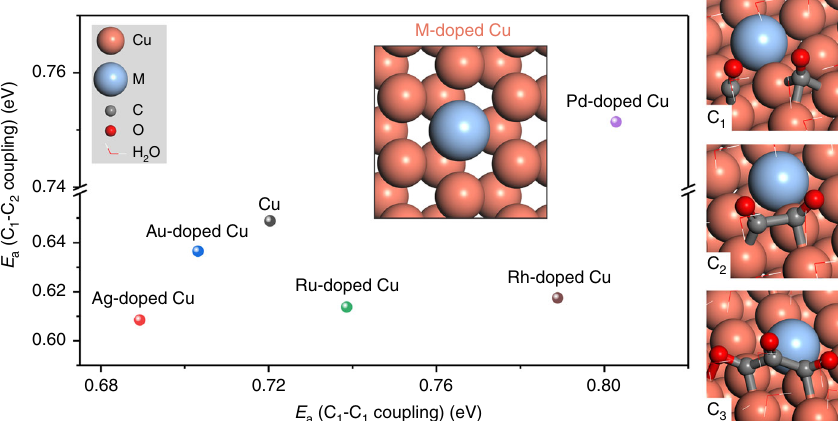
Fig. 1 DFT calculations on C 1 – C 1 and C 1 – C 2 coupling. DFT calculated reaction barriers ( E a ) for C 1 – C 1 and C 1 – C 2 coupling on screened M -doped Cu systems ( M = Ag, Au, Ru, Rh, and Pd). The geometries of M -doped Cu surface, C 1 , C 2 , and C 3 on M -doped Cu are shown with the corresponding labels, respectively. Cu, M, C, and O are illustrated as orange, light blue, gray, and red balls, respectively, while water molecules are shown as